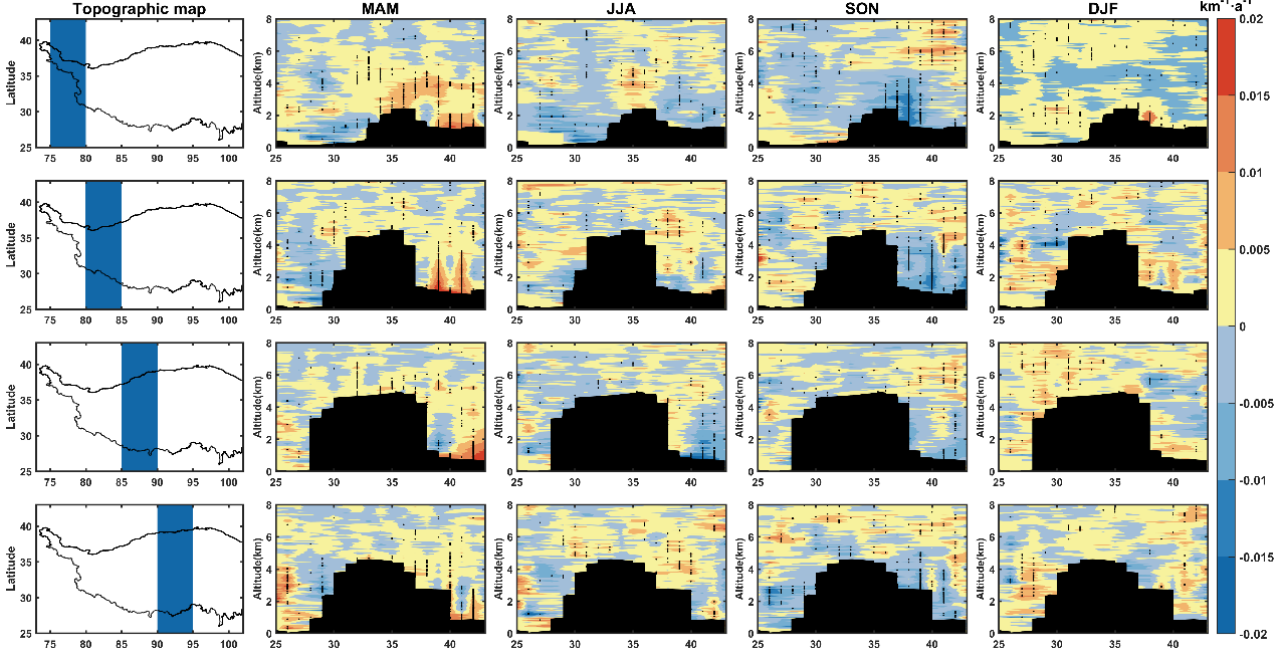
Figure 6. Distributions of the linear annual trends of the seasonal dust extinction coefficient ( σ D ) at 532 nm on four longitudinal transects during 2007 − 2020. The black point represents the linear trend passing the significance test at the level of 0.05.